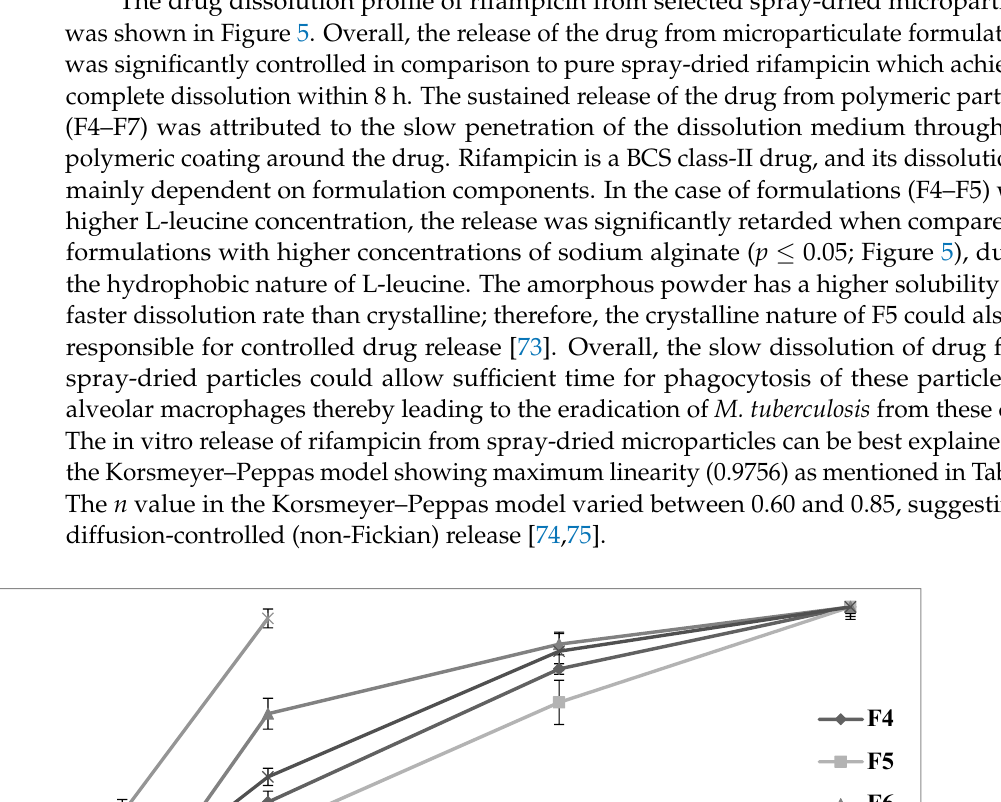
Figure 4. ( I ). FTIR Spectra of rifampicin (a), aloe vera (b), sodium alginate (c) and L-leucine; ( II ) (d)